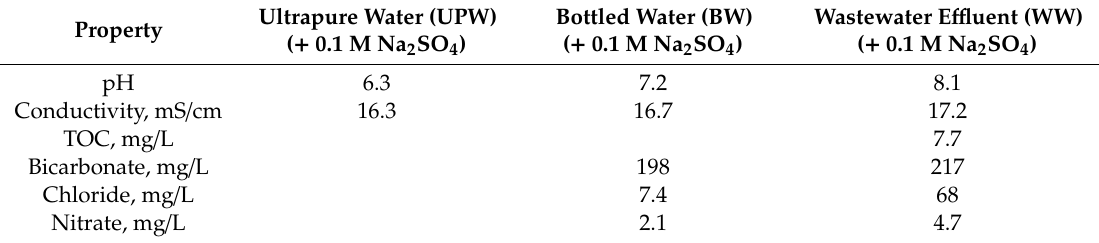
Table 1. Physico-chemical characterization of di ff erent water